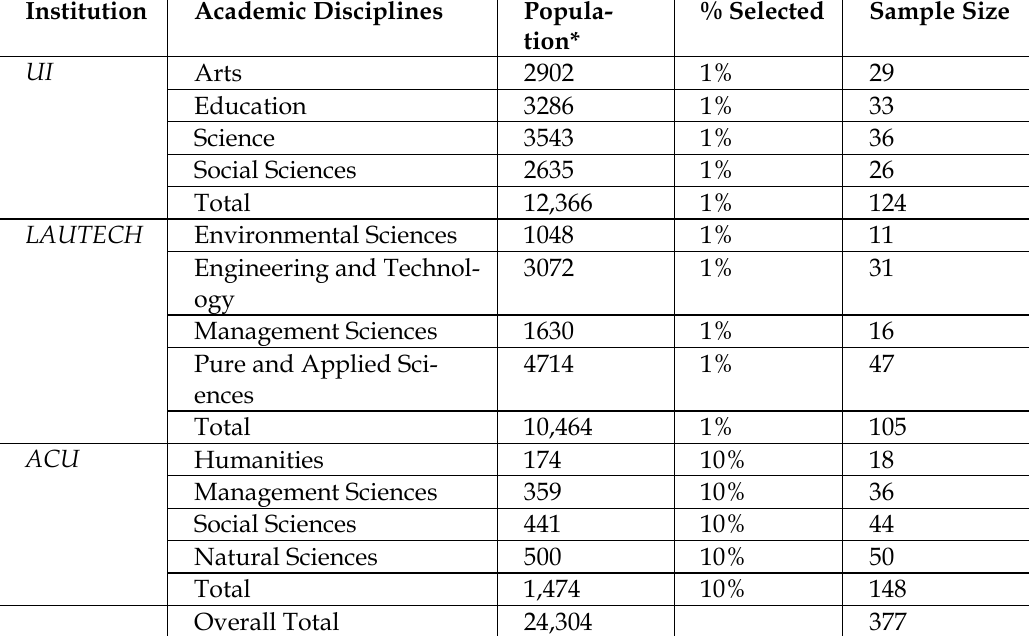
Table 1: Population of students at the three institutions based on selected faculties Institution